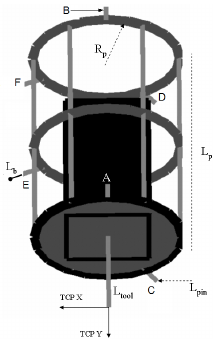
B . The arm with three links connects actuator q 3